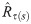
Selection for epidemics with interventions.Left graphs compare R^τ(s) estimates (blue with 95% confidence intervals) at the APE window length k* to those when k is set to its upper or lower limits. Right graphs give corresponding one-step-ahead predictions I^s given the window of data Iτ(s−1) (blue with 95% prediction intervals). Dashed lines are the true Rs numbers (left) and dots are the true Is counts (right). The panels examine (A) exponentially rising and decaying and (B) piecewise falling Rs due to differing interventions.